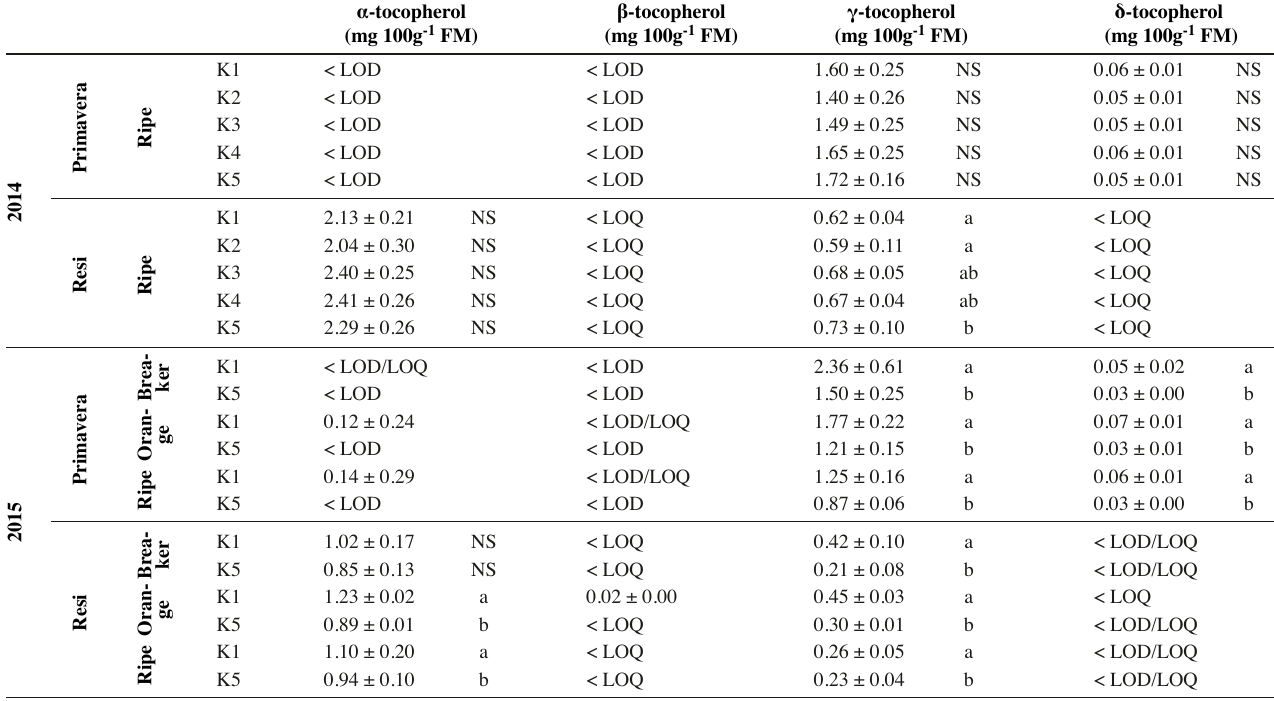
Mean values and standard deviations were determined from four biological replicates. K levels increase from K1 to K5 (0.37 g, 0.73 g, 1.47 g, 2.2 g, and 3.66 g K 2 SO 4 per week) for each cultivar. Letters indicate statistically significant differences, according to Mann-Whitney-U or Tukey-HSD test. NS indicates no significant difference. Below the limit of detection (< LOD). Below the limit of quantitation (< LOQ). If a tocopherol concentration was < LOQ for one or more of the biological replicates, < LOQ was given as the mean.